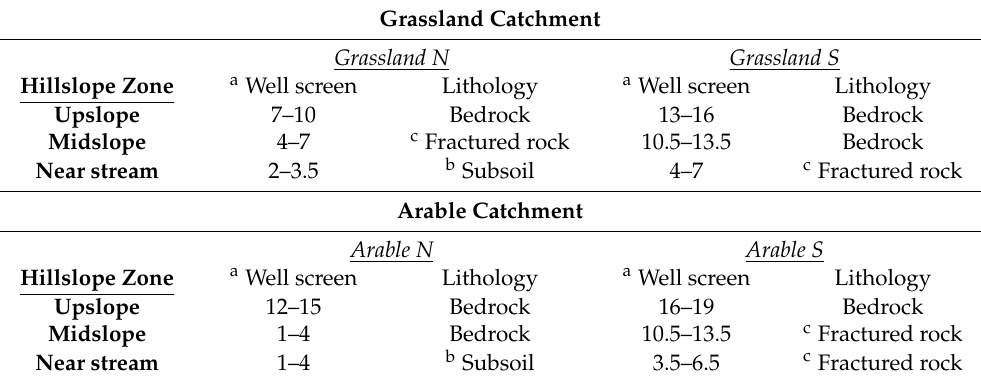
Hillslope Zone a Well screen Lithology a Well screen Lithology Upslope Bedrock Midslope 1–4 Bedrock Near stream 1–4 b Subsoil 3.5–6.5 c Fractured